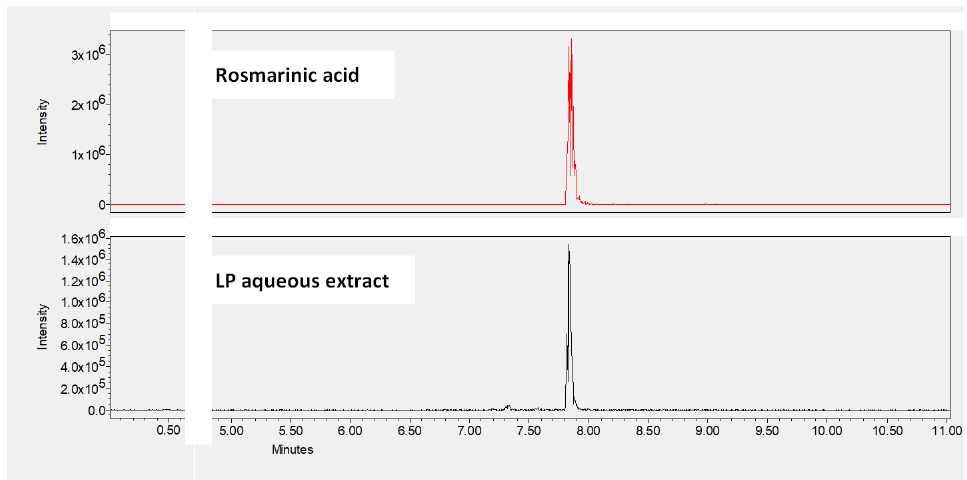
Figure 1. UHPLC-MS chromatograms showing the dominance of rosmarinic acid peak in LP aqueous extract.